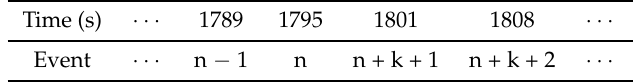
Table 11. An imagined sequence of price change events after the second thirty minute window has been removed.